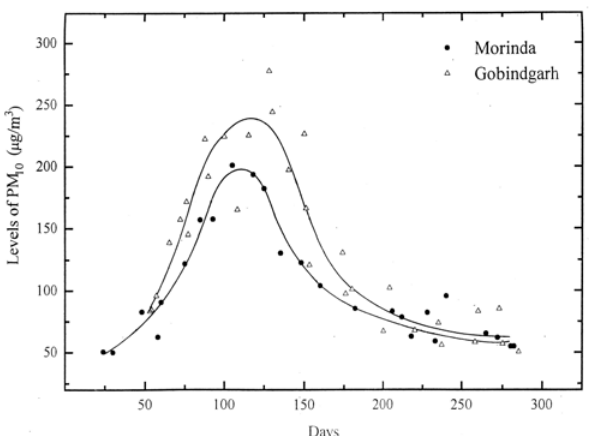
in the two study